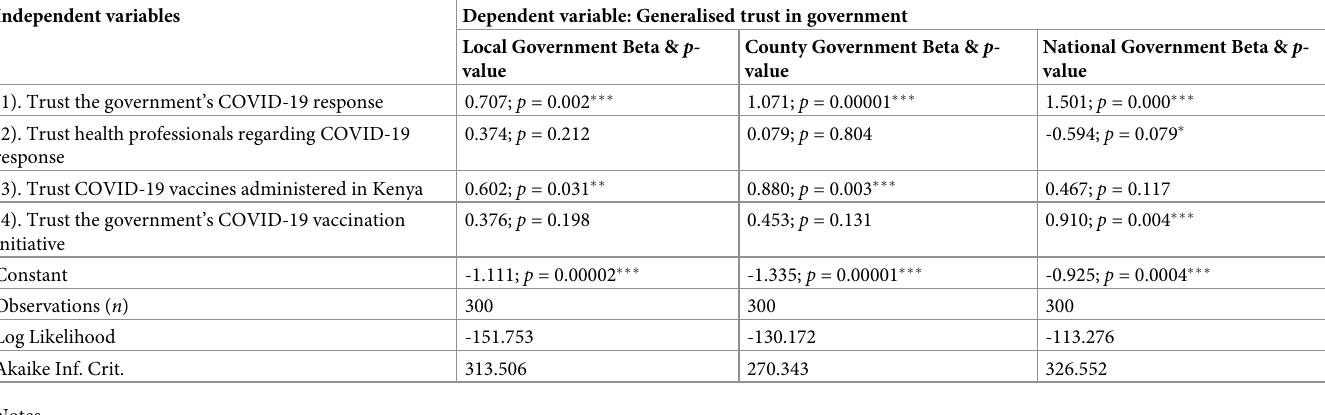
Table 5. COVID-19-related trust among self-confirmed CHVs (probit